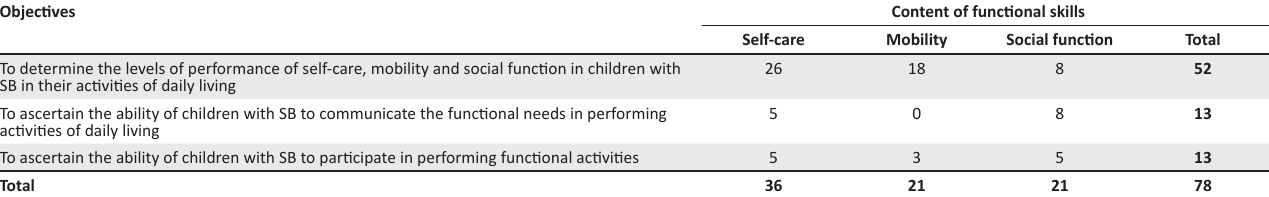
TABLE 3: Blue print showing the number of portions and items that were proposed for developing the measure.